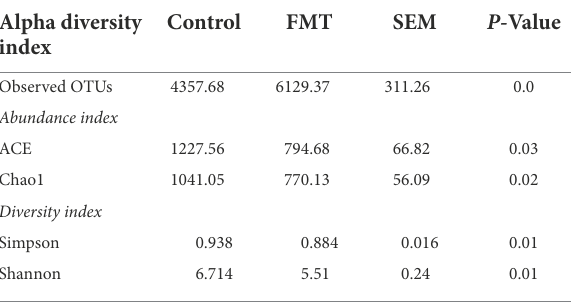
TABLE 3 Observed operational taxonomic units (OTUs) and α -diversity measures of bacterial communities between chicks from the control and fecal microbiota transplantation (FMT)